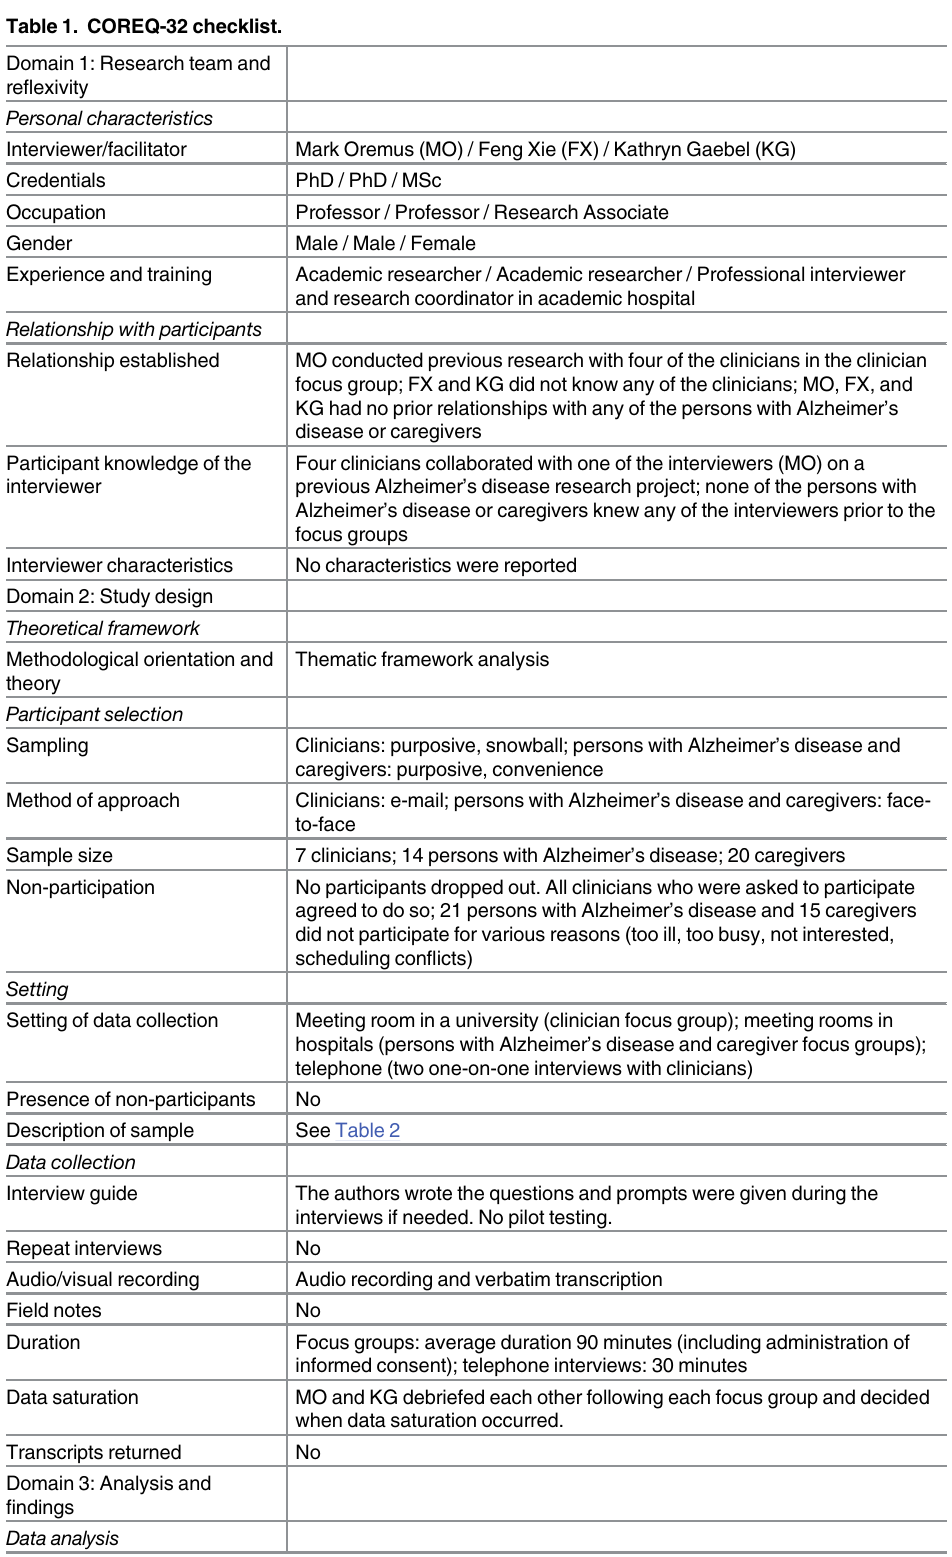
Table 1. COREQ-32